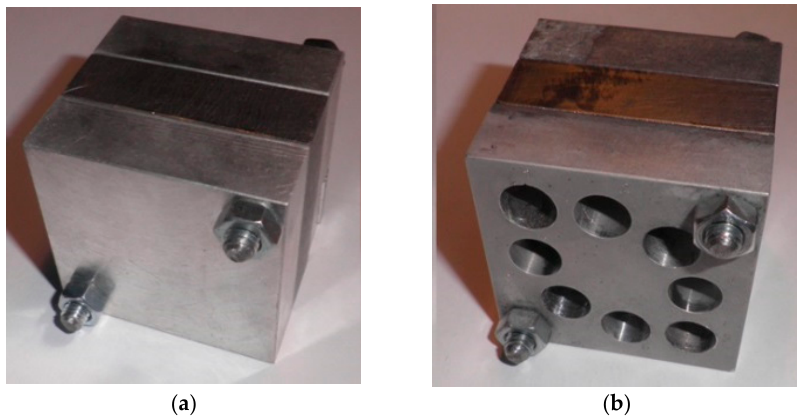
Figure 1. Hybrid magnesium–titanium–magnesium stack for ( a ) drilling and ( b ) hole repair